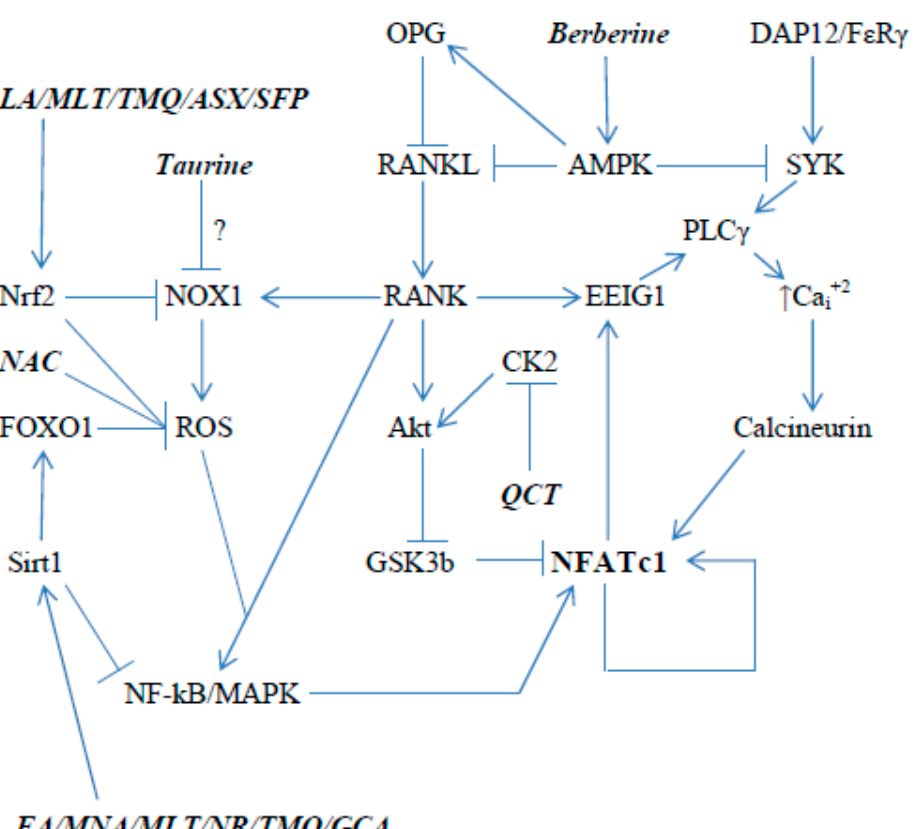
Figure 2. Nutraceutical modulation of osteoclast expression and activity of NFATc1, a key driver of osteolysis. LA = lipoic acid; MLT = melatonin; TMQ = thymoquinone; ASX = astaxanthin; SFP = sulforaphane; NAC = N-acetylcysteine; QCT = quercetin; FA = ferulic acid; MNA = N1-methylnicotinamide; NR = nicotinamide riboside; and GCA = glucosamine.